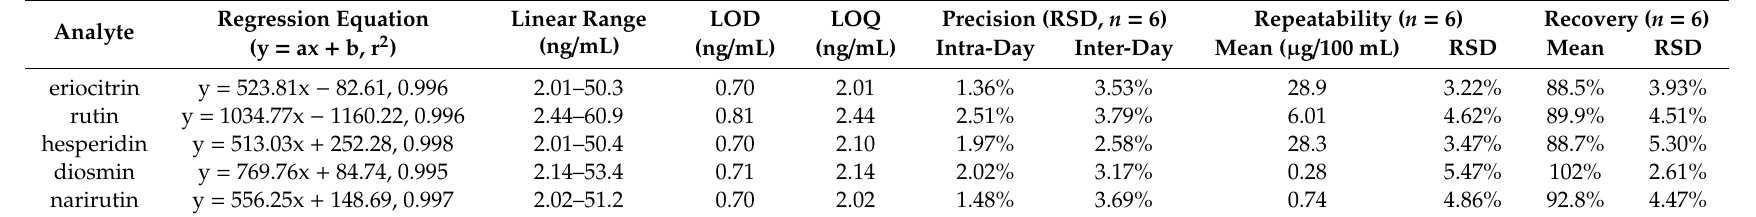
Table 3. The results of method validation.